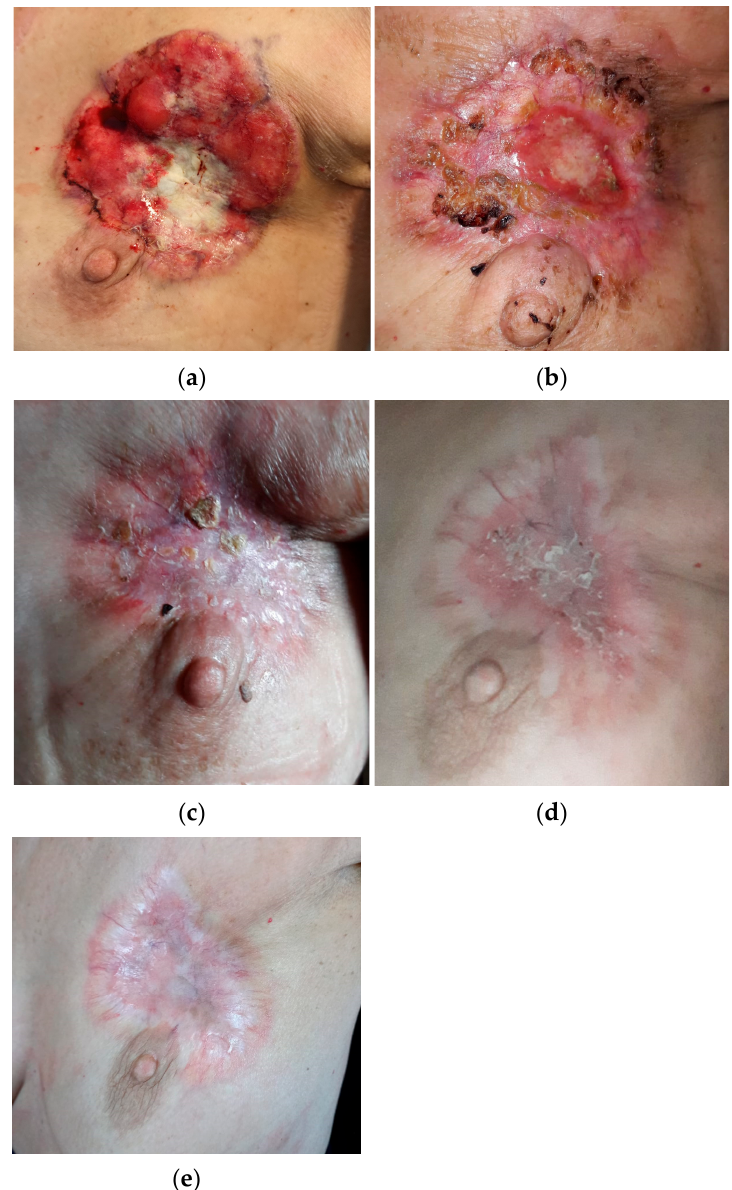
Figure 1. Baseline clinical evaluation and response over time of the primitive ulcerative breast lesion: ( a ) Clinical picture March 2021: left breast primitive neoplasm presenting as an ulcerative and bleeding lesion occupying the upper quadrants, about 10 × 70 mm in size; ( b ) Clinical picture May 2021: initial size reduction of the primary left breast neoplasm, in particular with respect to the actively bleeding area; ( c ) Clinical picture August 2021: reconstitution of intact skin, disappearance of bleeding and ulcerated areas; ( d ) Clinical picture November 2021: further dimensional reduction of the primitive left breast lesion, complete recovery of skin integrity; ( e ) Clinical picture March 2022 at one year from diagnosis.